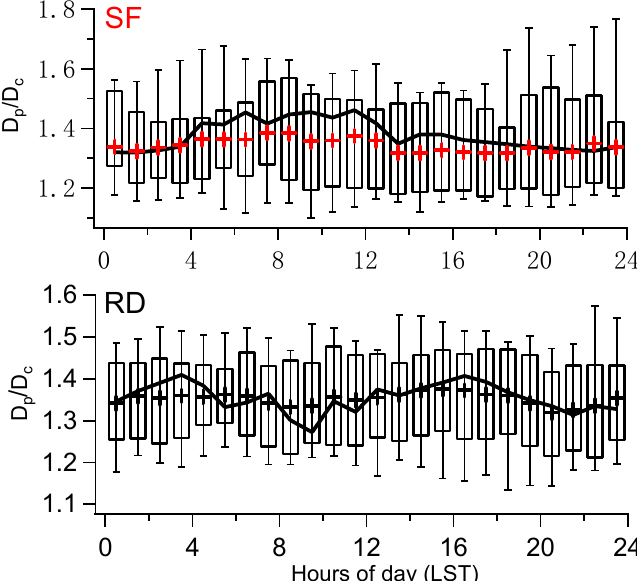
Figure 4. Mean diurnal variation patterns of D p / D c for spring festival and regular day (The upper and lower edges of the box denote the 25% and 75% percentiles, respectively. The lines in the middle of the box and cross markers indicate the median and average values respectively, with error bars explaining the 10% and 90% percentiles.).